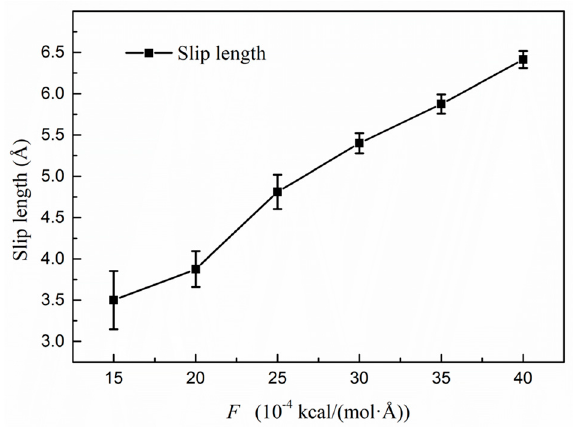
Figure 7. The slip length at different driving forces. T = 300 K.